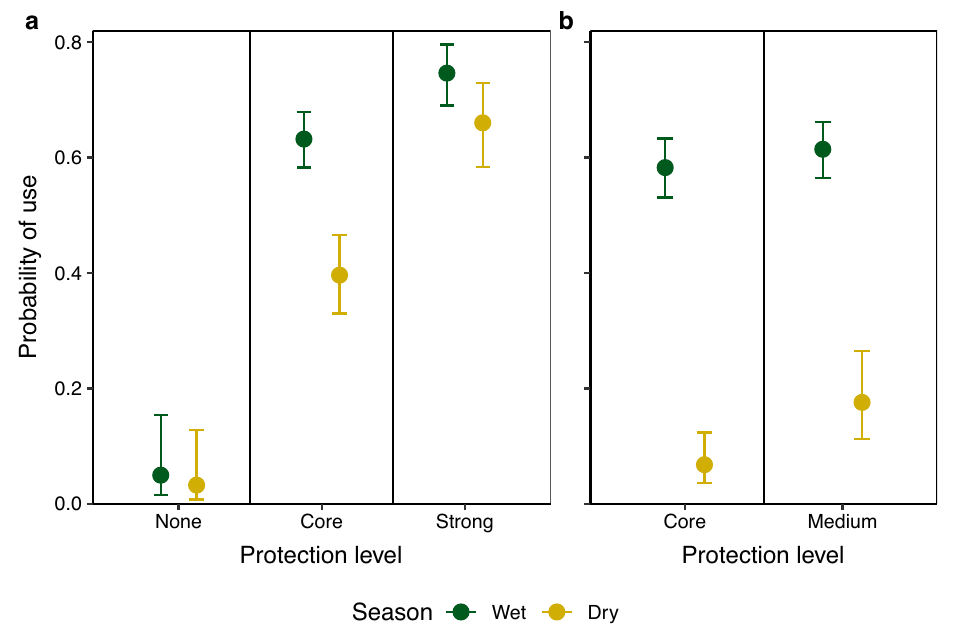
Figure 2. Lion probability of use and 95% confidence intervals in areas without protected status (“none”), core protected areas (“core”), buffer protected areas with medium protection (“medium”), and buffer protected areas with strong protection ("strong”) 38 during wet (November–May) and dry (June–October) seasons in the northern ( a ) and southern ( b ) study areas, holding other continuous variables constant at mean values and using categorical variables of female sex and cultivated land, Serengeti ecosystem, Tanzania, 2018–2019.